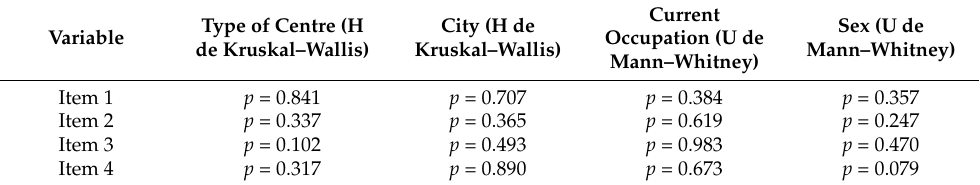
Table 3. Results based on the research items and groups of nominal variables.